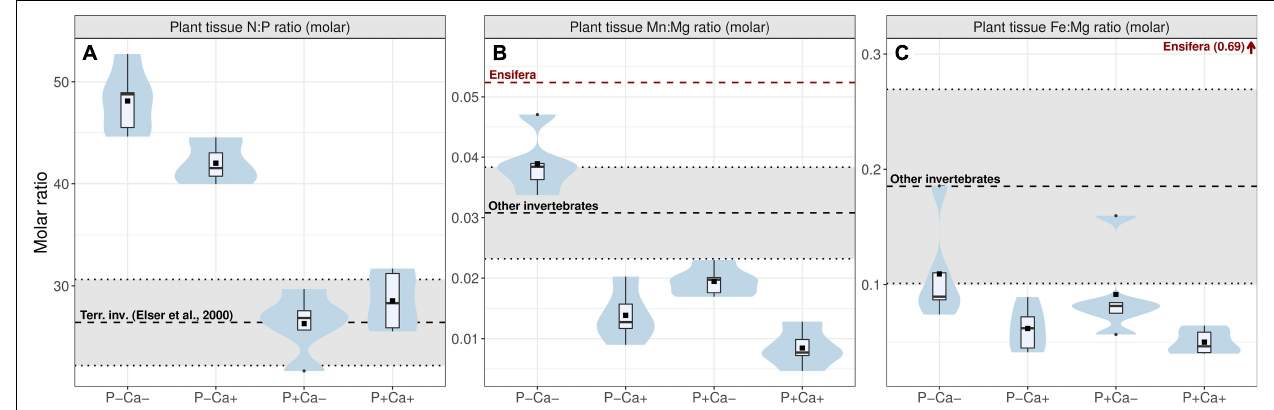
FIGURE 4 | Box-violin plots of treatment effects on plant tissue elemental stoichiometry. (A) N:P molar ratio; (B) Mn:Mg molar ratio; (C) Fe:Mg molar ratio of the Calluna/Molinia food mixture in the experimental fields. Bars represent bootstrapped 95% CI intervals, with group means as horizontal cross-bar. Black dashed horizontal line in A indicate mean tissue N:P ratio of terrestrial invertebrates (Elser et al., 2000a), black dashed horizontal line in (B,C) indicate mean tissue Mn:Mg and Fe:Mg ratio of invertebrates, red dashed horizontal line in (B) indicate Ensifera Mn:Mg ratio. Ensifera Fe:Mg ratio is indicated by an arrow with respective ratio in parentheses (for invertebrate elemental ratios, see Supplementary Table 1 ). Violins indicate data distribution. Boxes indicate 25, 50, and 75% quantiles, whiskers indicate all data within 1.5*interquantile range, dots represent outliers, squares indicate group mean. P+/P–: P treatment contrasts; Ca+/Ca–: lime treatment contrasts.